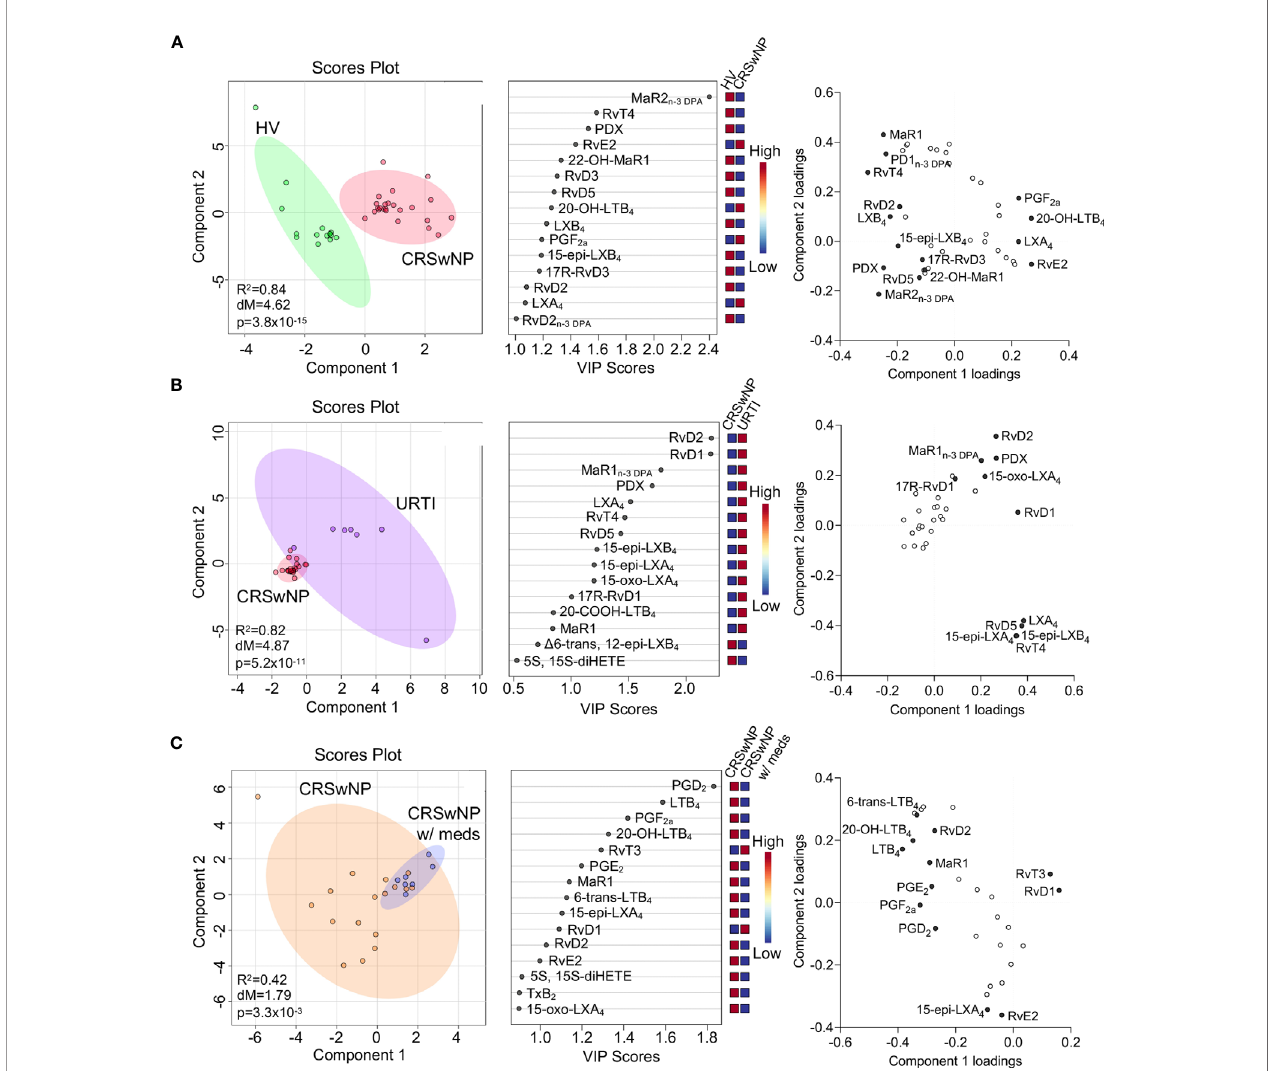
FIGURE 3 | Dysregulated lipid mediator pro fi les in plasma from CRSwNP when compared to both healthy volunteers and URTI. (A) Plasma was collected from patients with CRSwNP (n = 24) and healthy volunteers (HV, n = 15) LM concentrations were determined using LC-MS/MS based LM pro fi ling (see methods for details). Differences in LM concentrations were evaluated using PLS-DA. ( Left panel ) 2-dimensional scores plot and ( centre panel ) corresponding VIP plot of plasma LM. ( right panel ) loading plot where mediators with VIP score >1 are annotated. (B) . Plasma was collected from patients with CRSwNP (n = 24) and patients with URTI (n = 7) LM concentrations were determined using LC-MS/MS based LM pro fi ling (see methods for details). Differences in LM concentrations were evaluated using PLS-DA. ( Left panel ) 2-dimensional scores plot and ( centre panel ) corresponding VIP plot of plasma LM. ( right panel ) loading plot where mediators with VIP score >1 are annotated. (C) Plasma lipid mediator concentrations were evaluated in patients receiving medication and those that were not. ( Left panel ) 2-dimensional scores plot and ( centre panel ) corresponding VIP plot of plasma LM. ( right panel ) loading plot where mediators with VIP score >1 are annotated. N = 7 for patients receiving medications (CRSwNP w/meds) and n = 17 for patients not receiving medications (CRSwNP). Shaded areas represent 95% con fi dence interval (CI), R 2 = coef fi cient-of-determination, p = p-value from Hotelling ’ s T-squared test, dM = Mahalanobis distance between